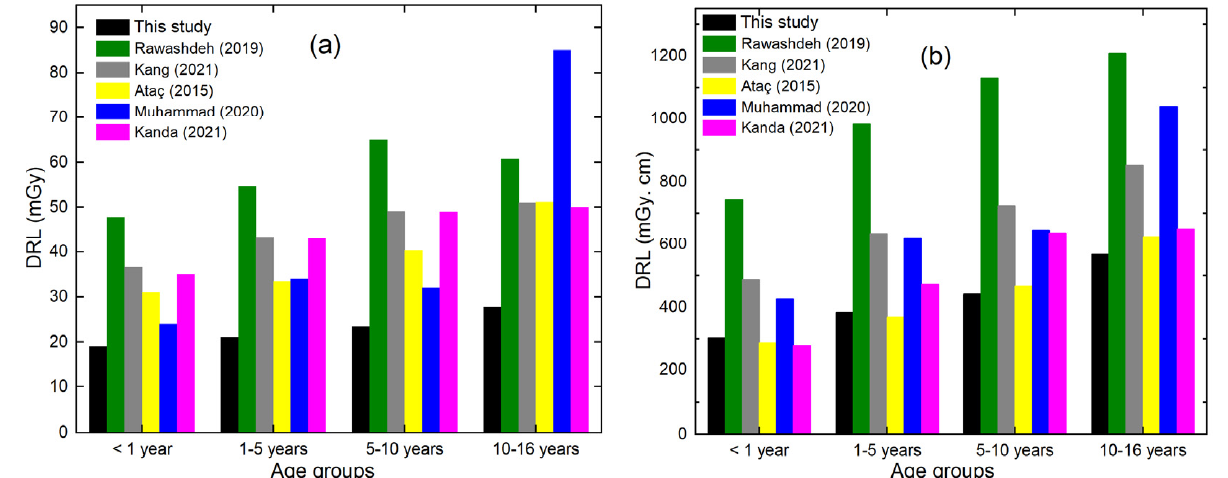
Figure 2. ( a ) Computed tomography DRLs (CTDIvol) for pediatric head CT scans; ( b ) computed